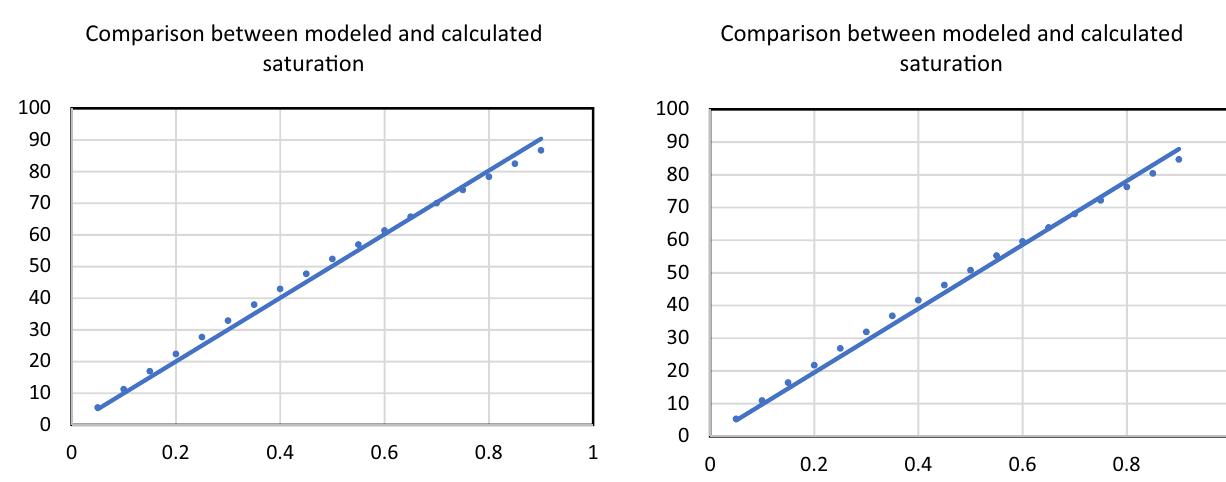
Fig. 30 Hydrocarbon saturation from density